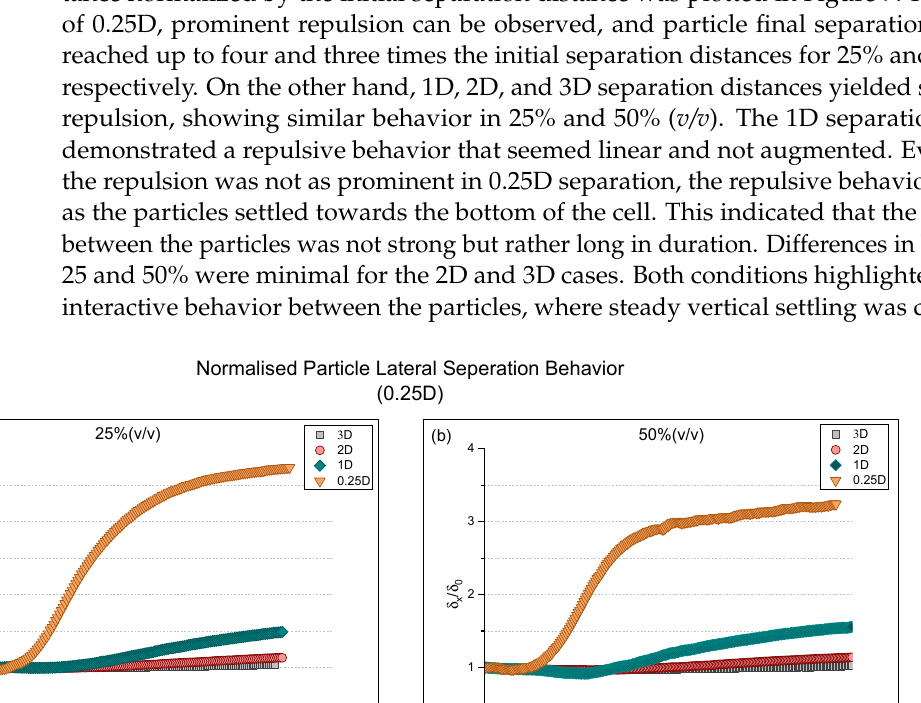
Figure 7. Plots representing particle normalized lateral separation distance (cid:4672) time for glycerin and water mixtures, ( a ) 25% ( v / v ) and ( b ) 50% ( v / v ), at various separation distances ( δ ) —3D, 2D, 1D, and 0.25D. The plots indicate an inverse relationship between initial and lateral separation distances.